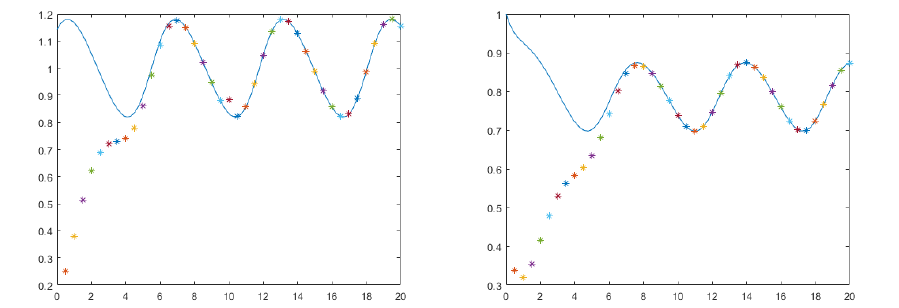
Figure 2. the solid lines correspond to u ∗ and v ∗ , respectively, and the stars to the values of the approximate solutions.